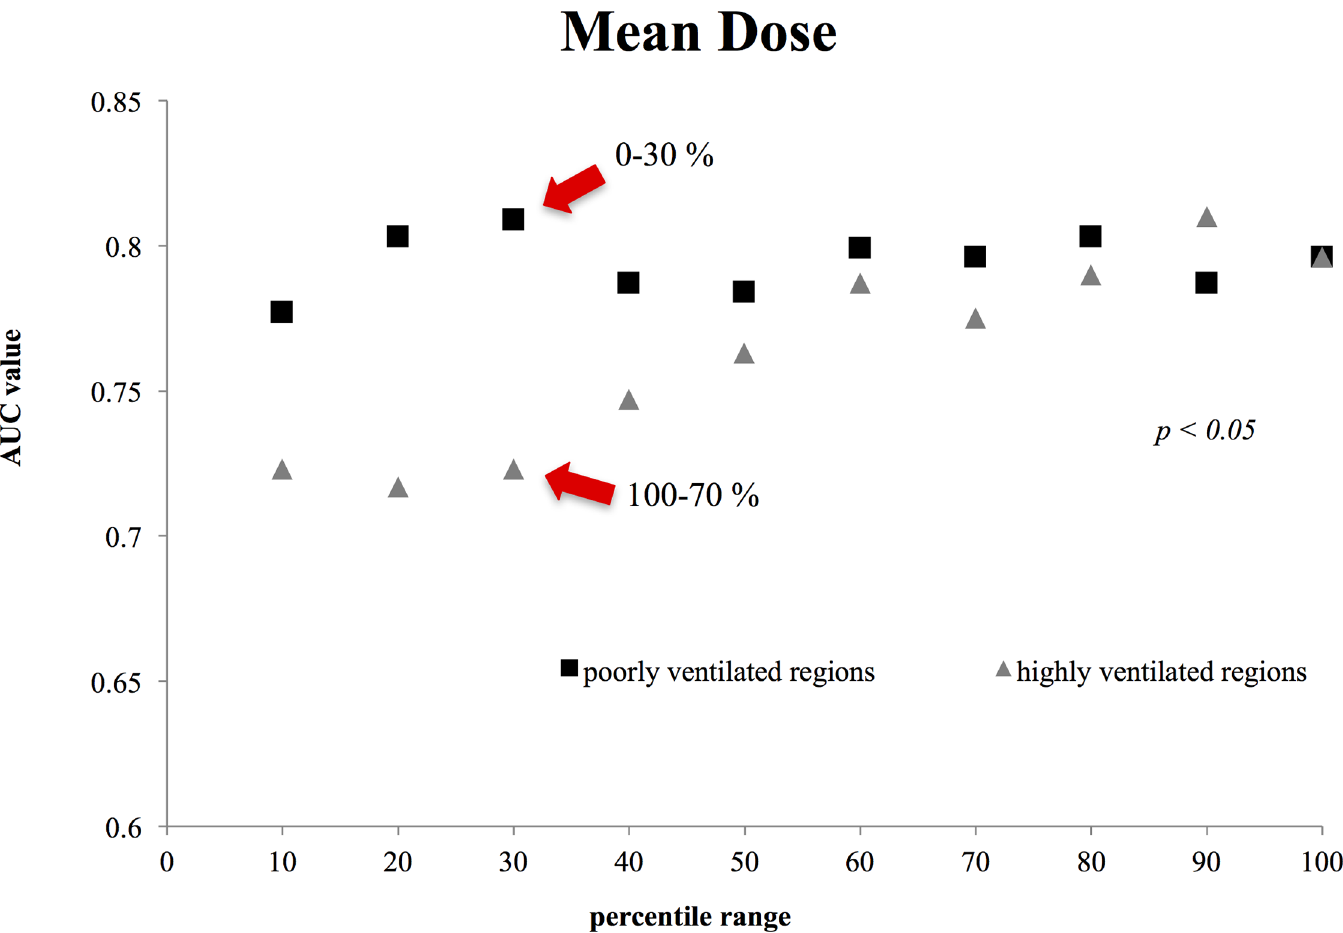
Fig 1. Comparison between the Mean Dose AUC values for highly and poorly ventilated regions. The difference in mean dose between poorly and highly ventilated regions was statically significant for each percentile range ( p = 0.0093; Student’s t -test).